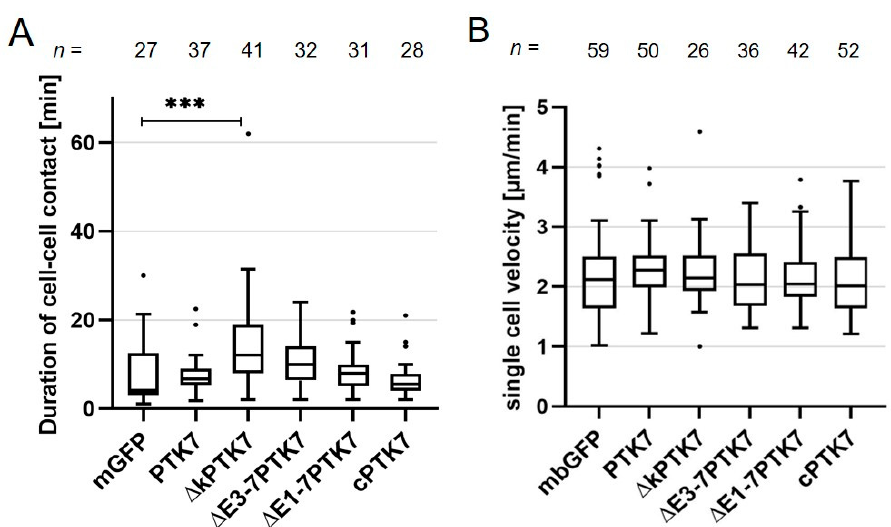
Figure 3. Dynamic localization of distinct Ptk7 deletion constructs during NC cell–cell contact. Two- cell stage Xenopus embryos were injected unilaterally with 200 pg Δ kPTK7-GFP , 200 pg Δ E3-7PTK7- GFP , 200 pg Δ E1-7PTK7-GFP, or 100 pg cPTK7-GFP RNA in combination with 200 pg H2B-mcherry RNA. NC cells were explanted at stage 16–18 and protein localization was analyzed by time lapse microscopy. ( A ) Images show NC cells before (first column), during (second column; 0 min), and after (third column) cell–cell contact. The respective constructs are indicated for each lane. Δ kPTK7- GFP expressing NC cells showed strong protein accumulation at cell–cell contact sites and often remained connected via nanotube-like structures after they separated (red arrows). Δ E3-7PTK7- GFP, Δ E1-7PTK7-GFP, and cPTK7-GFP were not enriched at cell–cell contacts. Yellow dotted arrows indicate the direction of migrating NC cells. NC cell–cell contacts are indicated by white arrows and shown at higher magnification in the boxed areas. Scale bar = 20 µm or 5 µm for higher magnifica- tion. ( B ) Graph showing the average fluorescence intensity at the cell–cell contact site normalized to control sites for NC cells expressing the indicated Ptk7 deletion constructs or mbGFP. Average values and standard errors of the mean are shown for 18 PTK7-GFP, 22 mbGFP, 28 Δ kPTK7-GFP, 22 Δ E3-7PTK7-GFP, 15 Δ E1-7PTK7-GFP, and 12 cPTK7-GFP expressing NC cells of at least three independent experiments. *** p < 0.005 for Δ kPTK7-GFP versus mbGFP (two-way ANOVA). The data for mbGFP and PTK7-GFP have already been shown in Figure 1B.